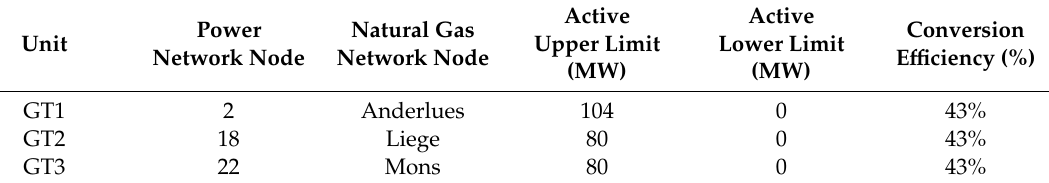
Table 1. Gas turbine related parameters.